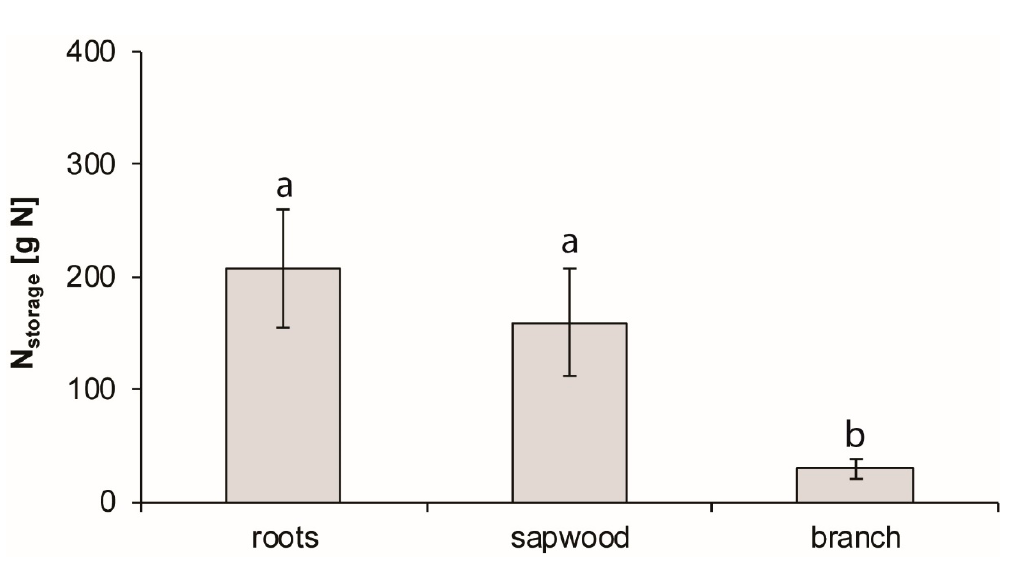
Figure 4. Total N storage of coarse roots, sapwood, and branches of Fagus crenata Blume. The error bars denote SD ( n = 9) , p < 0.01.